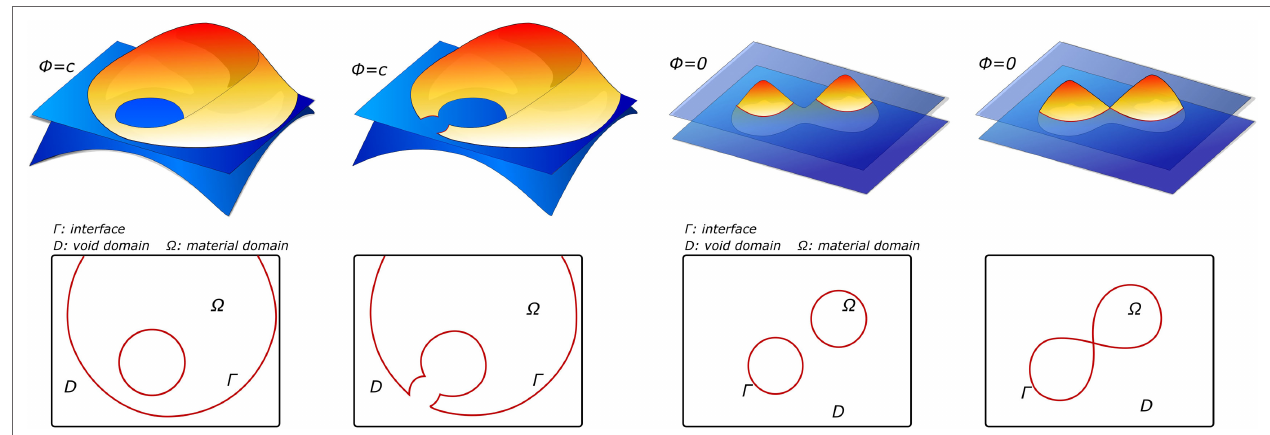
FIGURE 6 | Examples of level-set functions ϕ and their corresponding material domain Ω before and after the design update, adapted from Dijk et al. (2013) .